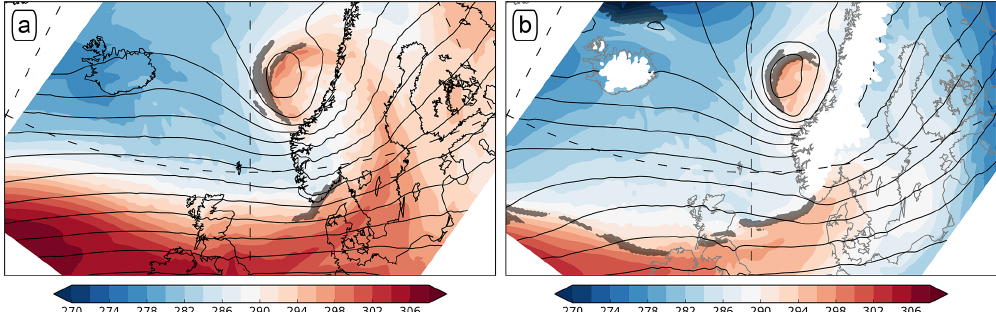
Figure 6. As Fig. 2g, but for (a) 700hPa and (b)